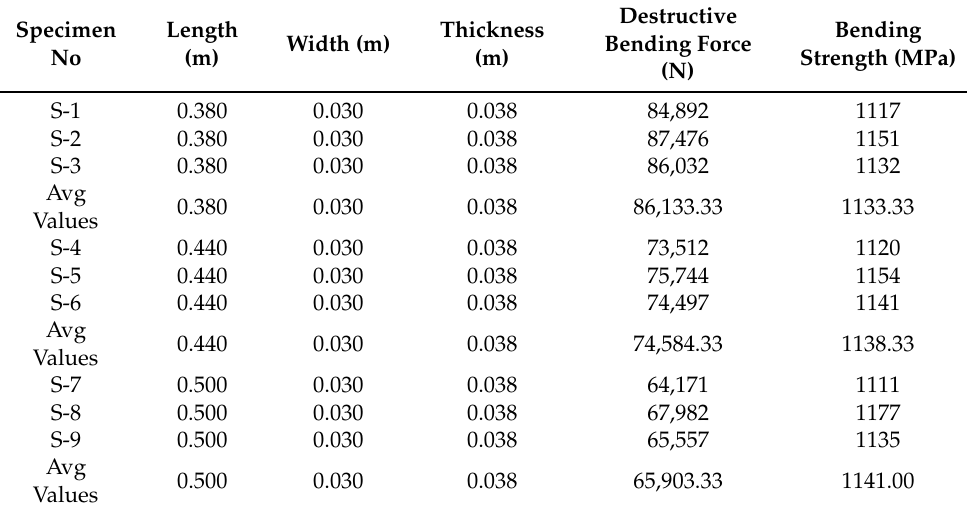
Table 7. Experimental evaluation of bending strength of the thick laminate.